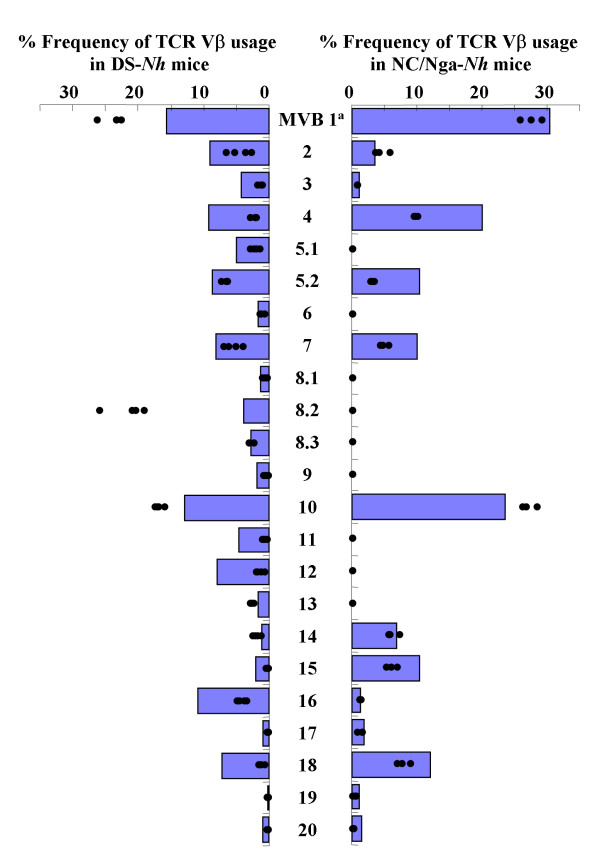
TCRBV repertoire analysis. The TCRBV repertoires in spleen cells from five DS-Nh or NC/Nga-Nh mice without in vitro stimulation.Bar indicates mean +2 SD of the TCRBV repertoires in spleen cells from five DS-Nh or NC/Nga-Nh mice without in vitro stimulation. Each dot indicates the percentage frequency of TCRBV-bearing T cells in spleen cells stimulated in vitro with SEC.